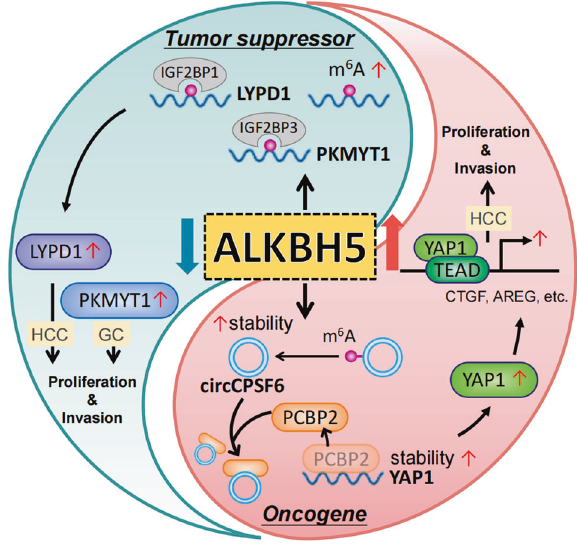
Fig. 3 The “ yin and yang ” effect of ALKBH5 in GI cancer development. The oncogenic ALKBH5 demethylates m 6 A modi fi